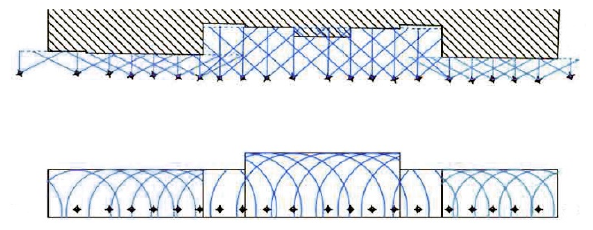
Figure 5. Plan and front view of the project scans in standard conditions – graphic elaboration by Maria Chiara Pugliese